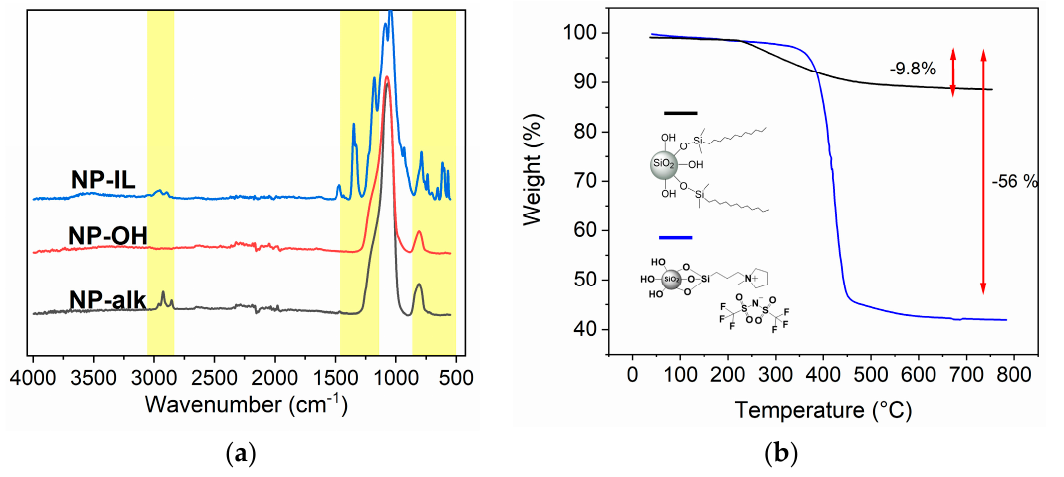
Figure 4. ( a ) FT − IR spectra of nanoparticles NP − IL (blue), NP − OH (red) and NP − alk (black); ( b ) TGA Figure 4. ( a ) FT–IR spectra of nanoparticles NP–IL (blue), NP–OH (red) and NP–alk (black); thermograms of NP − Alk (black) and NP − IL (blue). ( b ) TGA thermograms of NP–Alk (black) and NP–IL